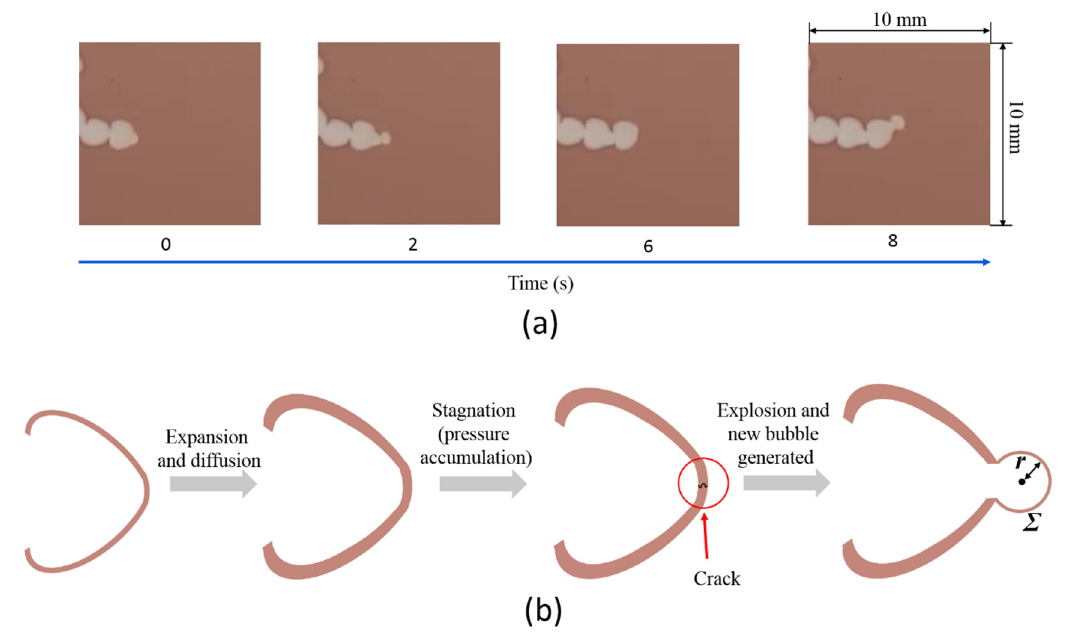
Figure 8. ( a ) Sequential growth of bubble-like finger structure that appears at a citric acid concentra- tion c of 15 wt%, injection speed Q of 15 mL/h, and gap width b of 0.4 mm. ( b ) Illustration of the growth of fingertip comprising expansion, stagnation, and explosion.